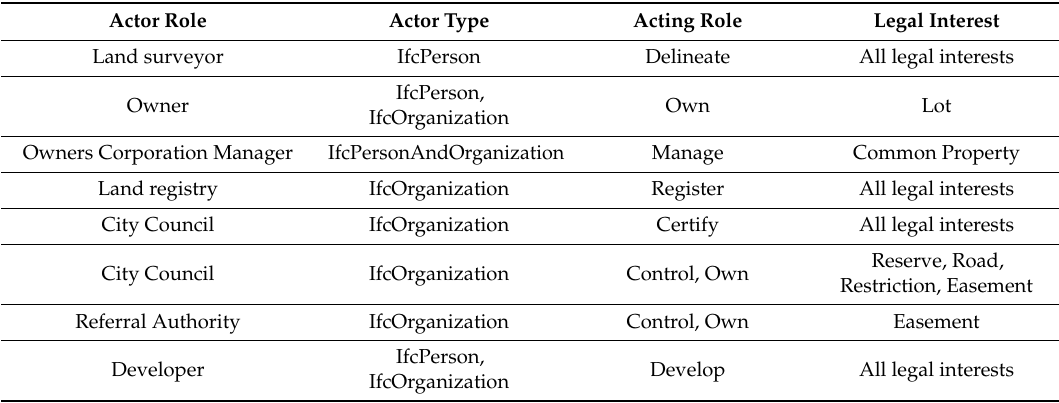
Table 1. Actor roles and legal